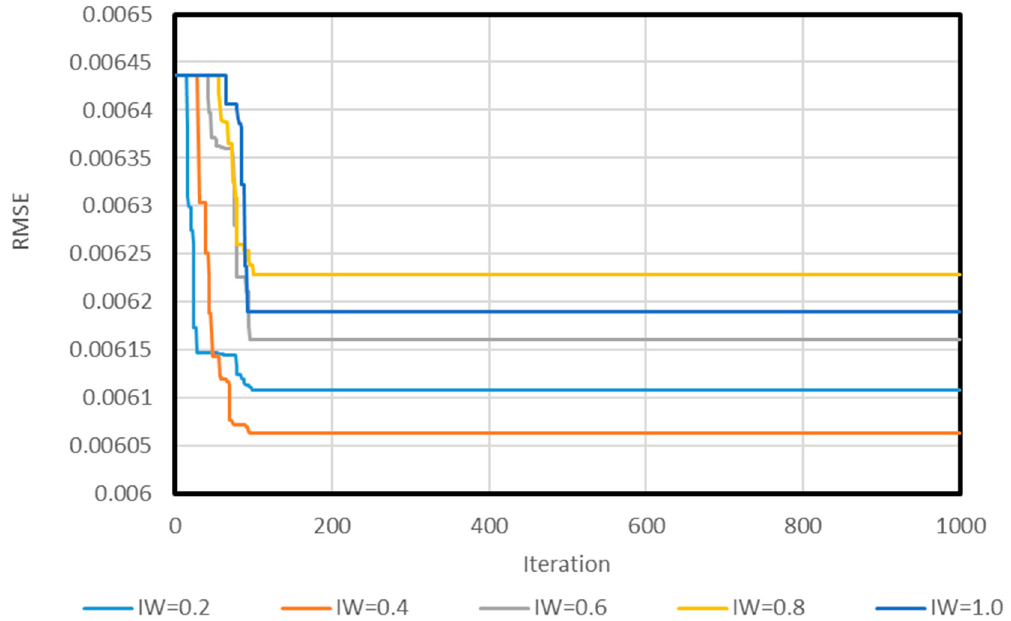
Figure 11. Efficiency results for various inertia weight amounts.